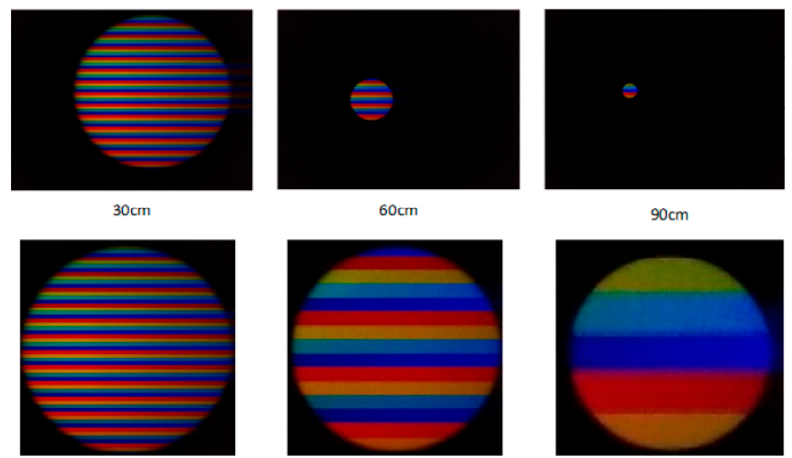
Figure 7. The number of stripes varies with distance.